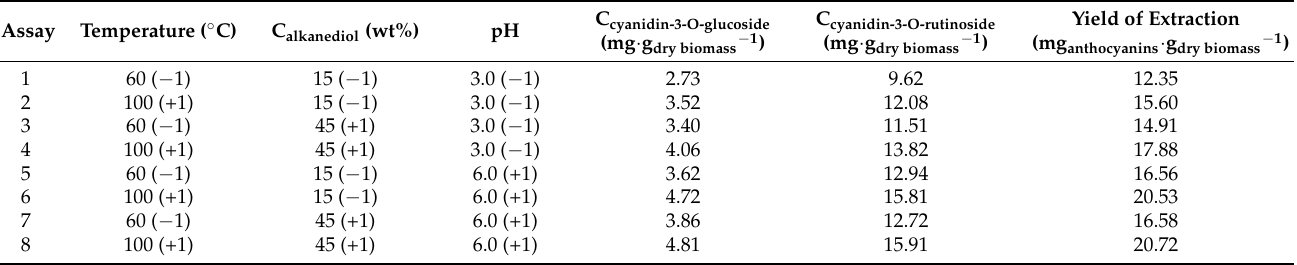
Table 1. Central composite rotatable design (CCRD) for the independent variables considered for the PLE extraction with aqueous solutions of 1,2-propanediol from juçara fruit samples at the pressure of 10 MPa and flow rate of 1 mL/min, as well as the results obtained for the extraction assays in terms of yield of extraction of